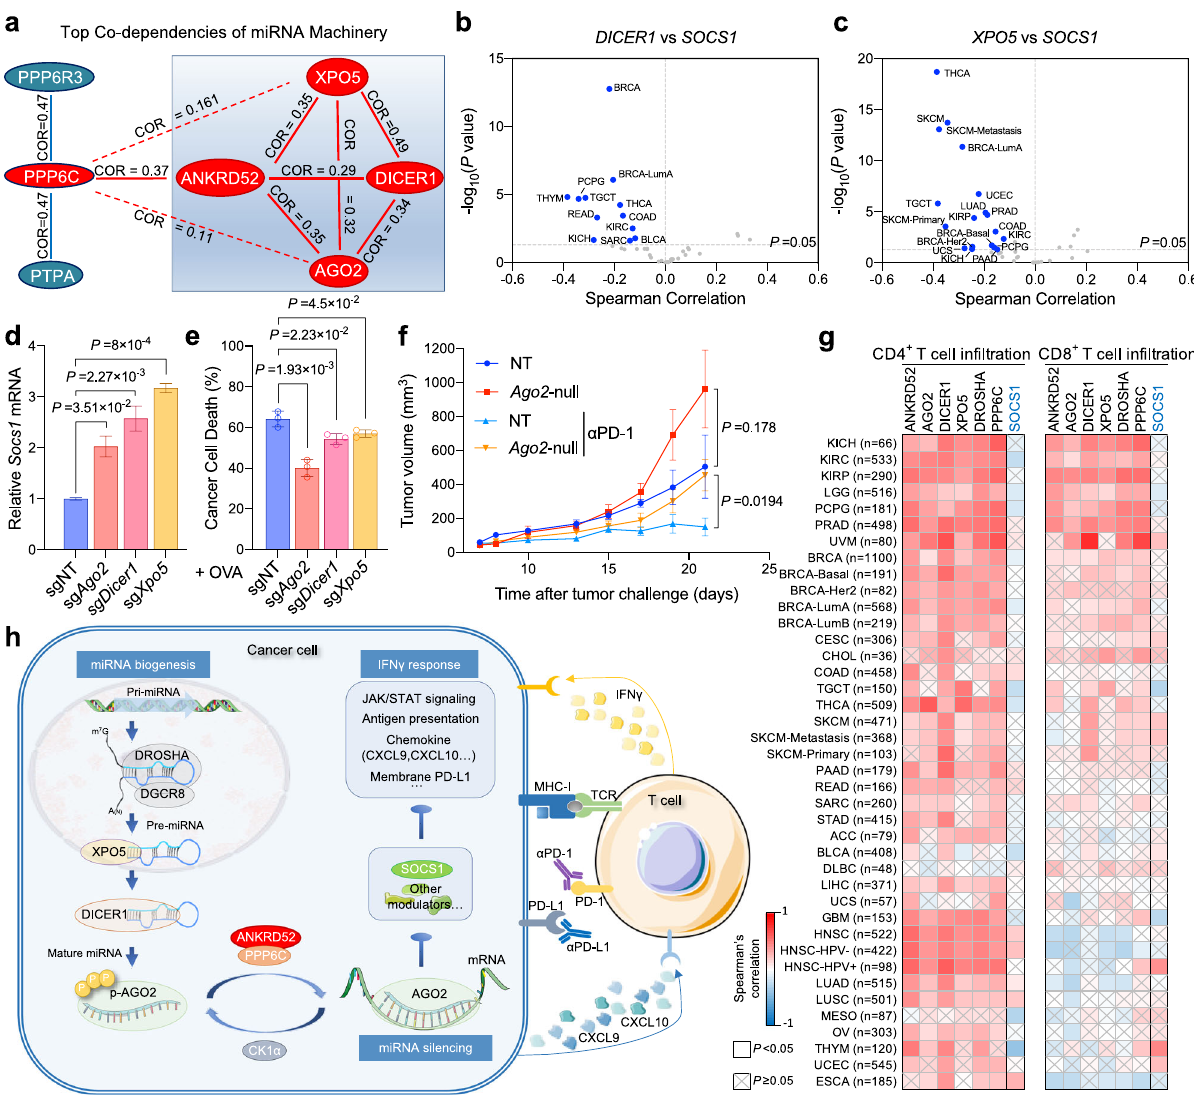
Fig. 7 Inactivation of miRNA machinery promotes cancer-intrinsic escape from T cell elimination. a Diagram showing the Spearman ’ s correlation of top co-dependent proteins with ANKRD52 or PPP6C in CRISPR (Avana) Public 20Q3 database. Solid lines depict signi fi cant positive correlations (Correlation > 0.25, P < 0.001) and dashed lines depict weak correlation (Correlation > 0.1, P < 0.01). b , c Volcano plot showing the Spearman ’ s correlation and estimated signi fi cance of DICER1 ( b ) or XPO5 ( c ) with SOCS1 mRNA levels from RNA-seq data across all TCGA cancer types. Each dot represents a cancer type in TCGA; blue dots indicate signi fi cant negative correlations ( P < 0.05, TIMER). d SOCS1 mRNA level in MC38 cells with targeted sgRNAs ( n = 3 per group). Data are representative of three independent experiments and represented as mean ± s.e.m., signi fi cance was determined using two- tailed unpaired Student ’ s t -test. e Killing of OVA-treated MC38 cells with targeted sgRNAs by OT-I T cells ( n = 3 per group per condition). Data are representative of two independent experiments and represented as mean ± s.d., signi fi cance was determined using two-tailed unpaired Student ’ s t -test. f Tumor growth curves of Ago2 -null or control MC38 tumors in WT mice treated with PD-1 antibody or not ( n = 5 for NT tumor, n = 6 for NT with anti-PD- 1 and n = 7 for Ago2 -null with or without anti-PD-1). Data are represented as mean ± s.e.m., signi fi cance was determined using two-tailed unpaired Student ’ s t -test. g Heatmap showing the Spearman ’ s correlation of ANKRD52 , AGO2 , DICER1 , XPO5 , DROSHA , PPP6C , or SOCS1 mRNA levels with CD4 + and CD8 + T cell abundance in tumors across all TCGA cancer types. h Model of miRNA machinery in regulation of cancer-intrinsic evasion from T cell attack. See also Supplementary Figs. 12 – 15. Source data are provided as a source data fi